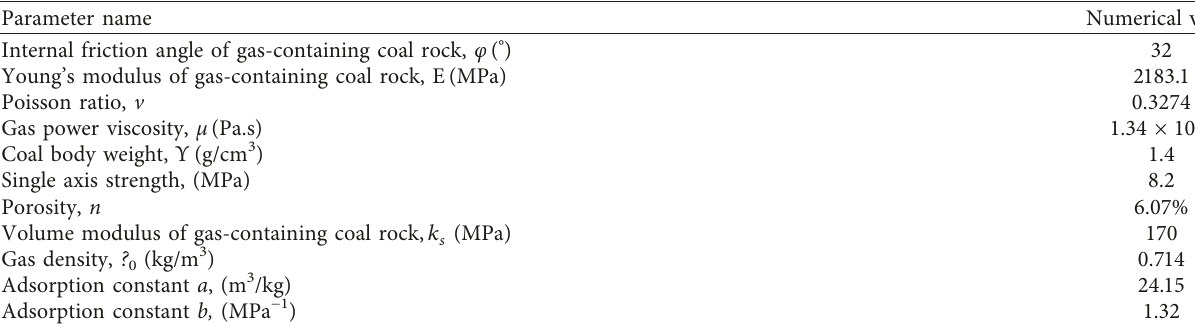
Table 3: Modeling parameters for the numerical